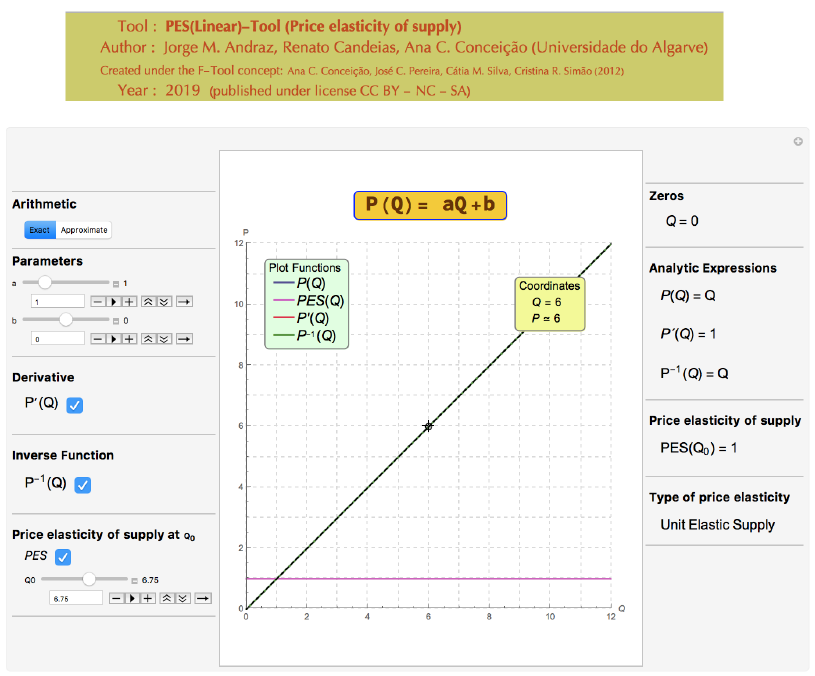
Figure 12. Example of an unit elastic supply with a derivative value equal to 1.